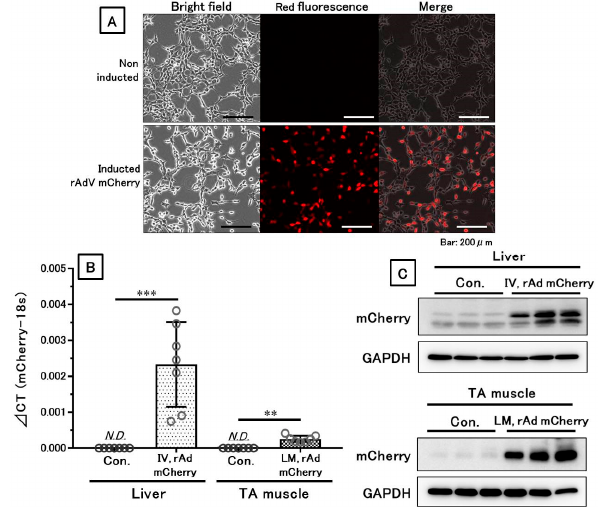
Figure 2. Confirmed gene and protein expression by the recombinant adenoviral (rAdV) vector. RNA and functional proteins were sufficiently expressed both in vitro and in vivo. ( A ) Functional protein expression of mCherry in HEK 293A cells. ( B ) Gene expression of mCherry in the liver or tibialis anterior (TA) muscle, detected by qPCR. ( C ) Protein expression of mCherry in the liver or TA muscle, shown by Western blotting of representative samples. IV means intravenous injection, and LM means local muscular injection of the rAdV vectors in the TA muscle. **: p < 0.01, ***: p <